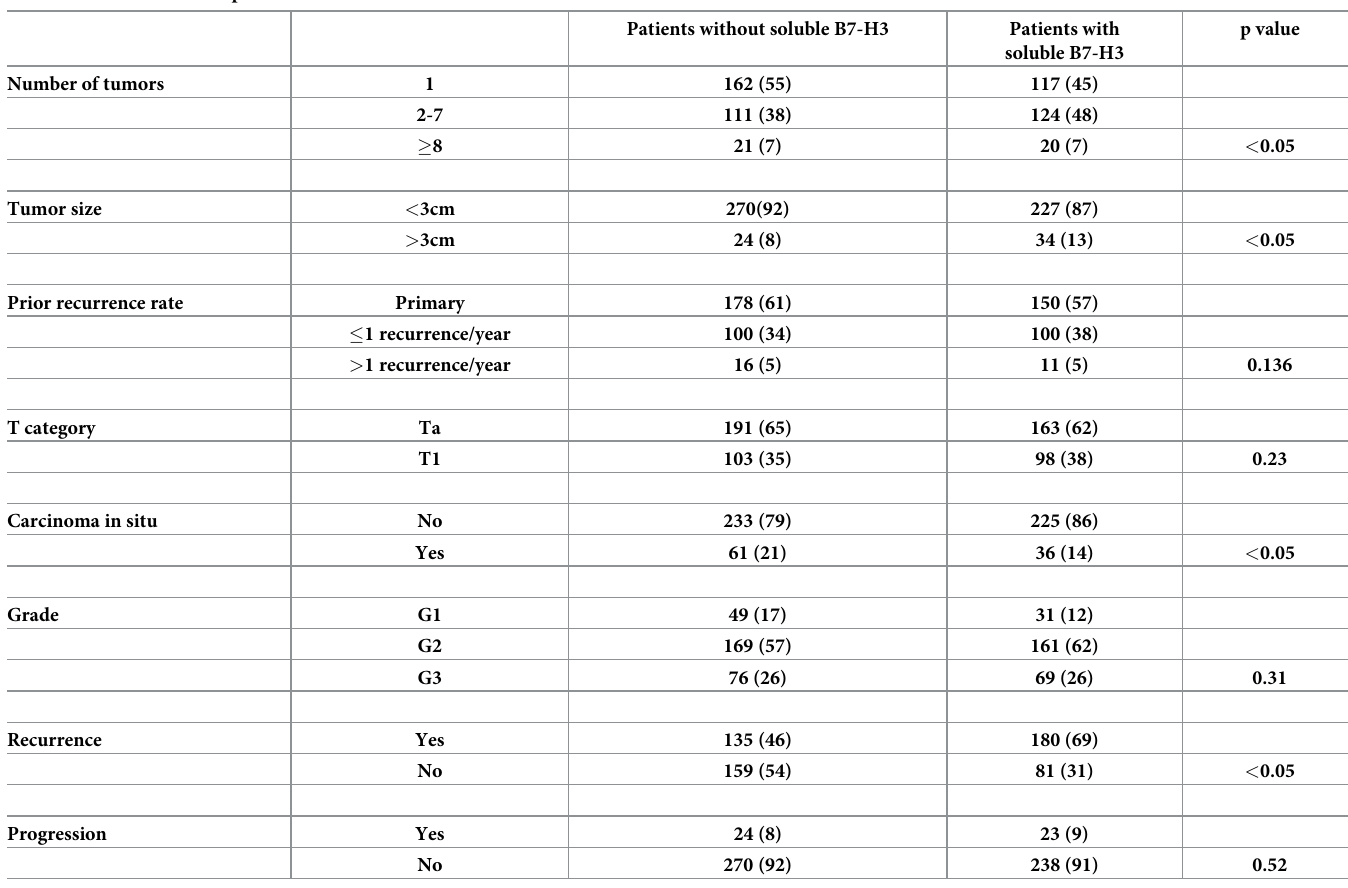
Table 2. Characteristics of patients with and without soluble B7-H3.